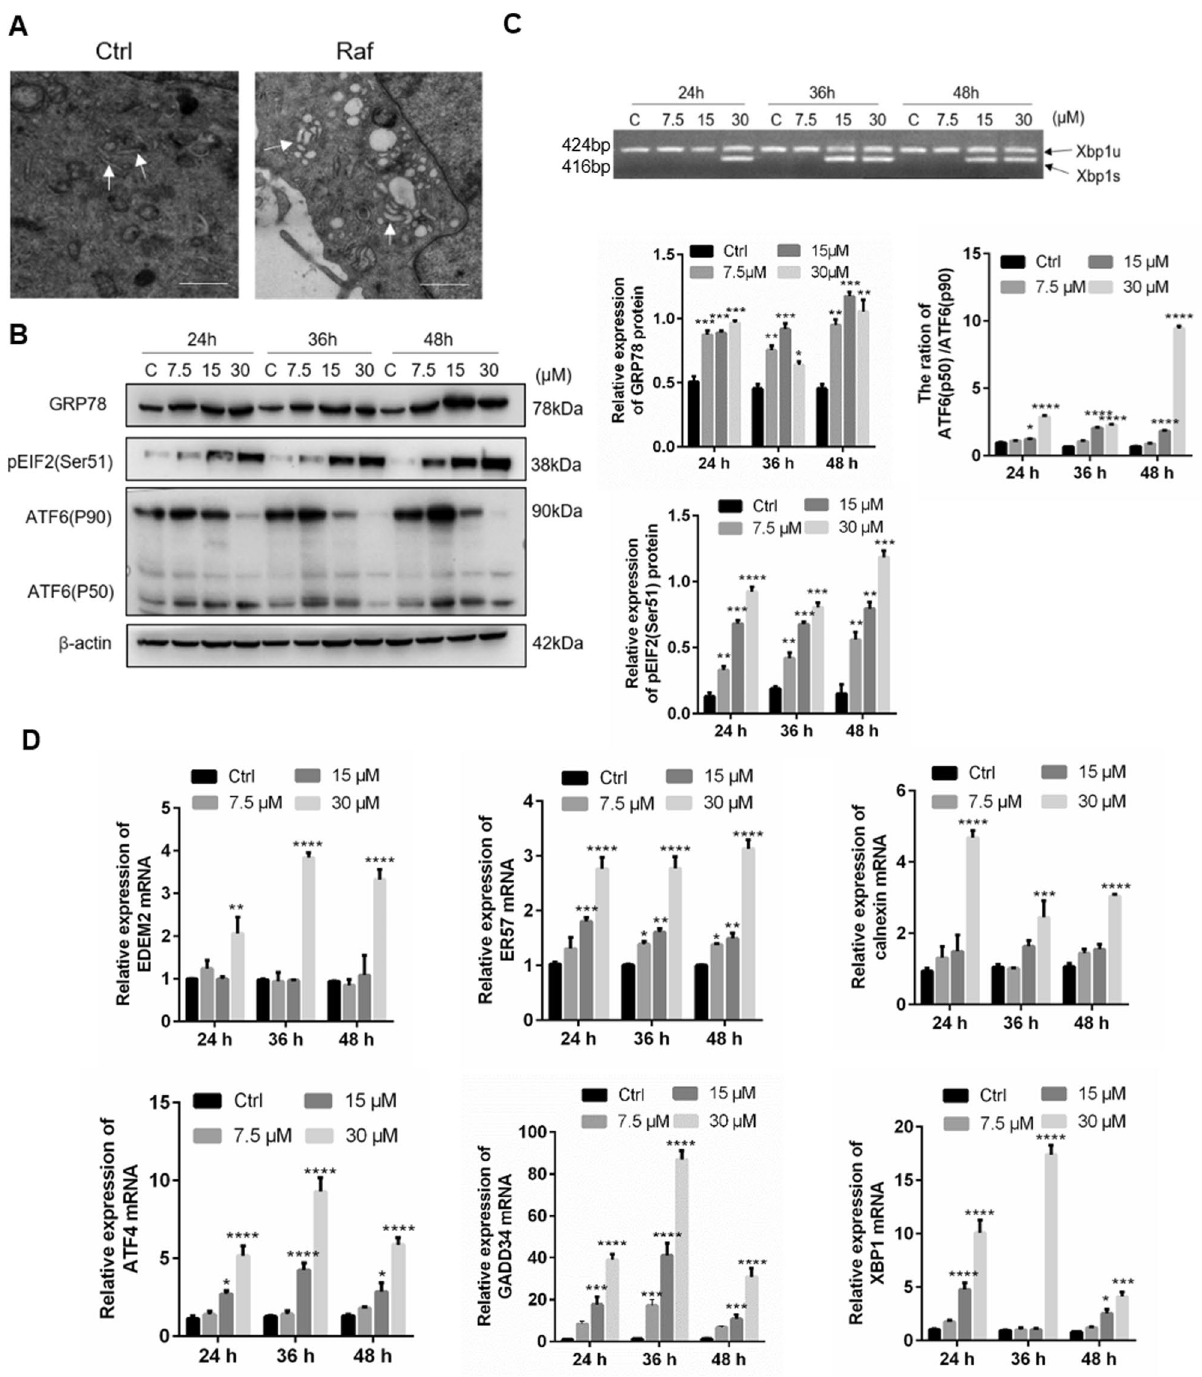
Figure 4. Rafoxanide promotes ERs and activates the UPR in A549 cells. ( A ) A549 cells were treated with 30 μM rafoxanide for 36 h. Cells were observed by electron microscopy. The ER (arrows) in cells is indicated. Scale bars, 500 nm. ( B ) A549 cells were treated with rafoxanide at different doses and cells were collected for western blot analysis at the indicated time points using antibodies against GRP78, pEIF2, and ATF6. β-actin was used as the loading control. The bar graph represents the quantitative analysis of western blots. ( C,D ) A549 cells were treated with rafoxanide (0, 7.5, 15, 30 μM) for 24, 36, 48 h. RNA was extracted from the treated and control cells. Both the unspliced and spliced forms of Xbp1 were analyzed by semi-quantitative RT-PCR. qRT-PCR was performed using primers specific for ATF4 , GADD34 , XBP1 , EDEM2 , ER57 , and calnexin . * P < 0.05, ** P < 0.01, *** P < 0.001, **** P <